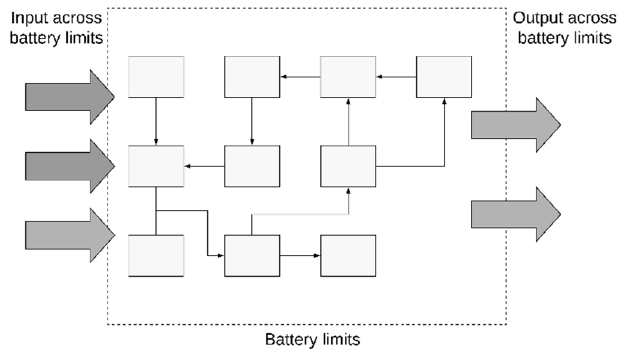
Figure 2. Illustration of battery limits for an industrial company at Mo Industrial Park (MIP). Only flows across the battery limits of companies are considered in this analysis.